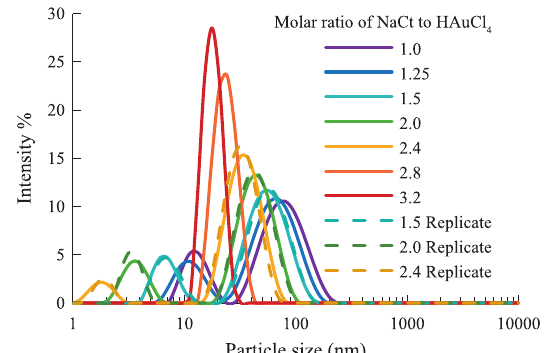
Fig. 2 The particle size of AuNPs increased as the molar ratio decreased. A bimodal distribution was observed for AuNP samples with MR ≤ 2.40. (System: 50 ml batch